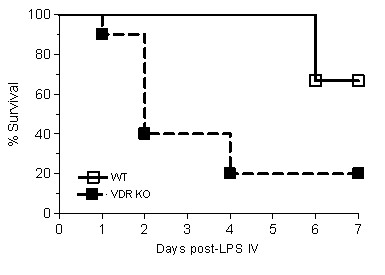
LPS induced endotoxemia. The survival of VDR KO (n = 11) and WT (n = 10) mice injected i.v. with 10 mg/kg LPS.